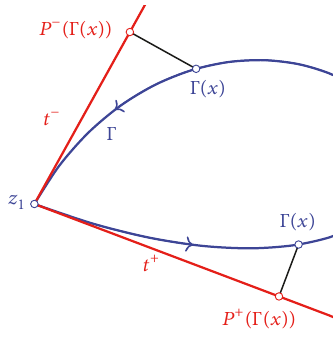
Figure 7: Γ is flat of order 𝑛 in 𝑥 1